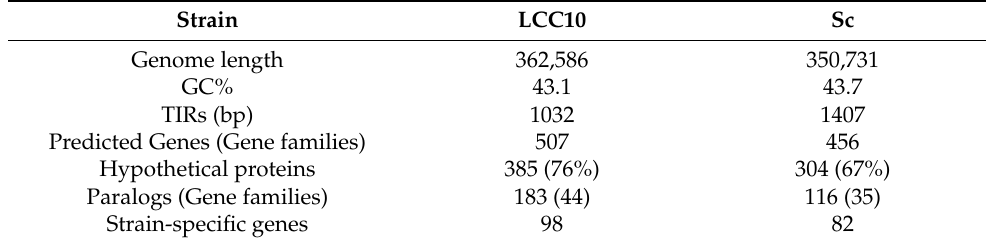
Table 1. Genomic features of